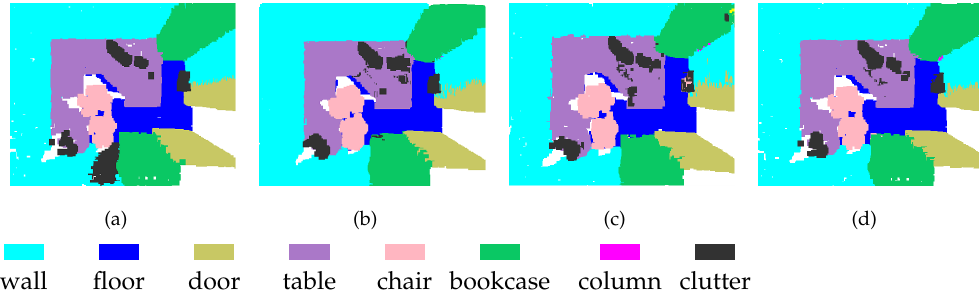
Figure 3. Segmentation results of point clouds with different densities: ( a ) ground truth; ( b ) point cloud at Level-1 ( P 1 ), where the sampling proportion is 1/2; ( c ) point cloud at Level-2 ( P 2 ), where the sampling proportion is 1/4; and ( d )